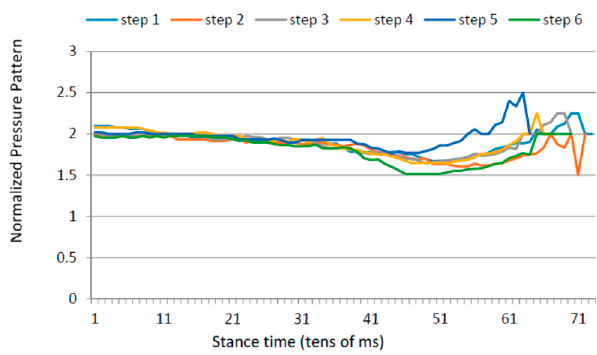
Figure 13. Lateral centre of pressure in the first six steps for a stroke survivor.